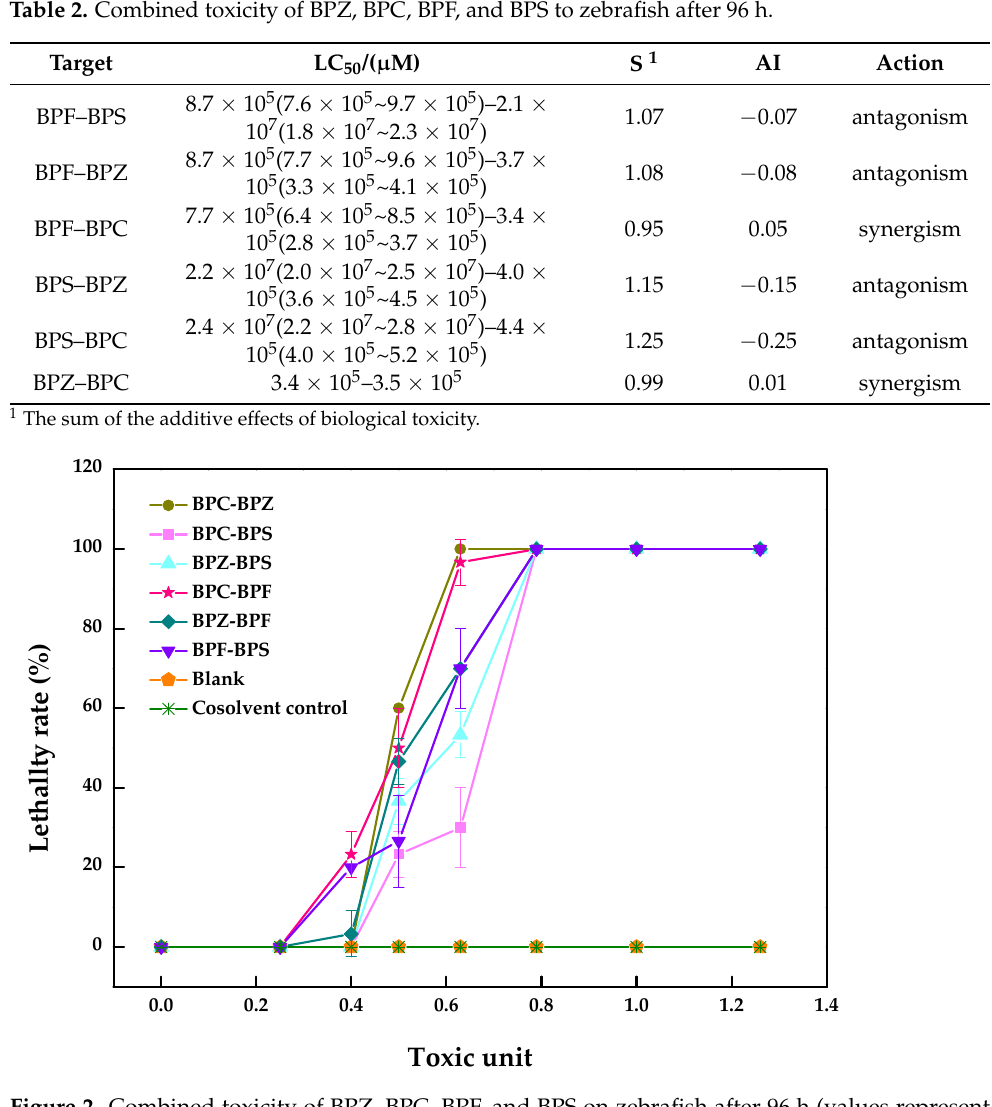
Figure 2. Combined toxicity of BPZ, BPC, BPF, and BPS on zebrafish after 96 h (values represent mean ± S.D., sample size: 3).